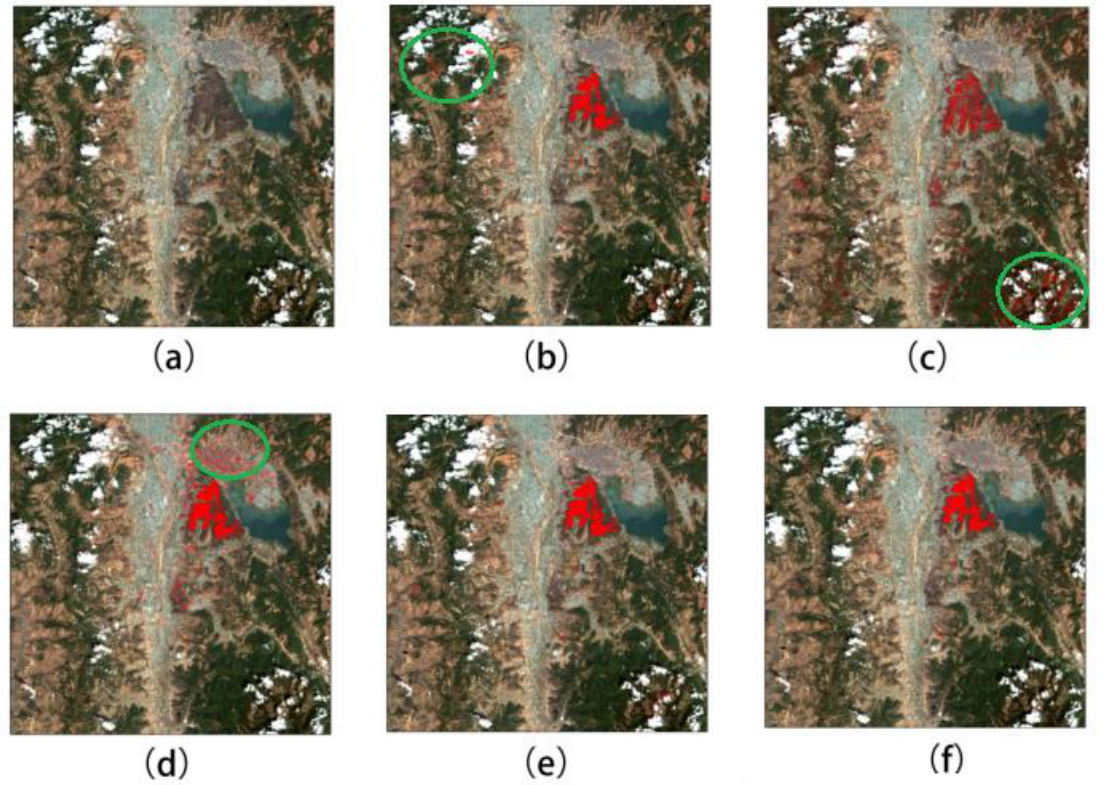
Figure 8. Display of Sentinel-2 image at Xichang city and associated image features derived from different spectral indices. ( a ) False color image (composite bands 12-8A-4); ( b ) NBR+; ( c ) BAI; ( d ) MIRBI; ( e ) ABAI; ( f ) MNBR. (Note clouds and shadows are mixed to the burned area and are highlighted with green circles)